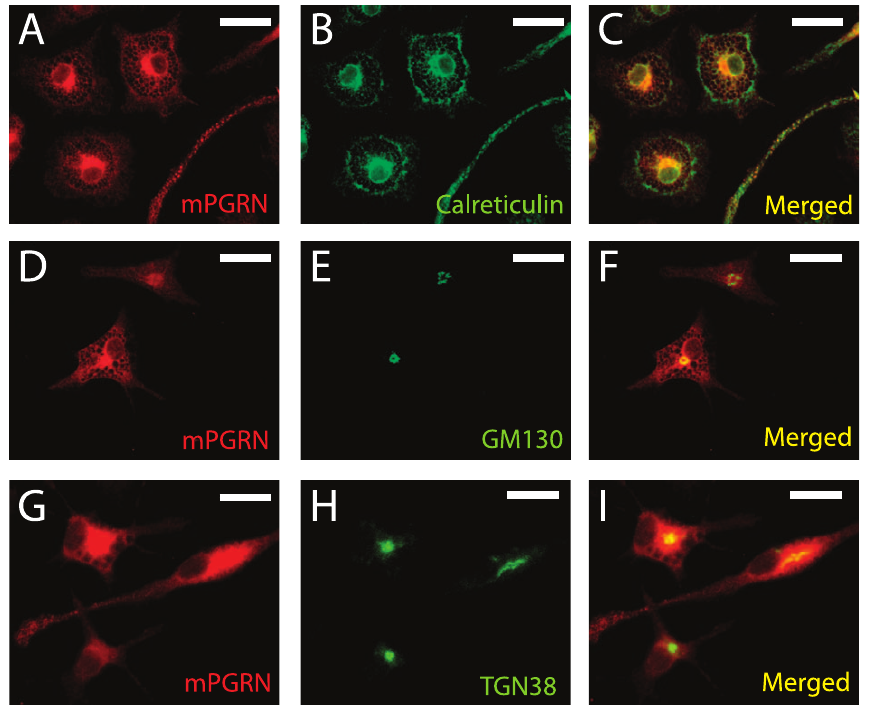
Figure 5. Subcellular localization of endogenous mPGRN in cultured primary microglia. ( A, D, G ) Immunostaining of endogenous mPGRN in cultured primary microglia. ( B ) immunostaining of the ER marker calreticulin in the microglia in (A). ( C ) Merged image of (A), and (B). ( E ) Immunostaining of the cis-Golgi marker GM130 in the microglia in (D). ( F ) Merged image of (D) and (E). ( H ) Immunostaining of the trans-Golgi marker TGN38 in the microglia in (G). ( I ) Merged image of (G) and (H). Scale bar: 20 m